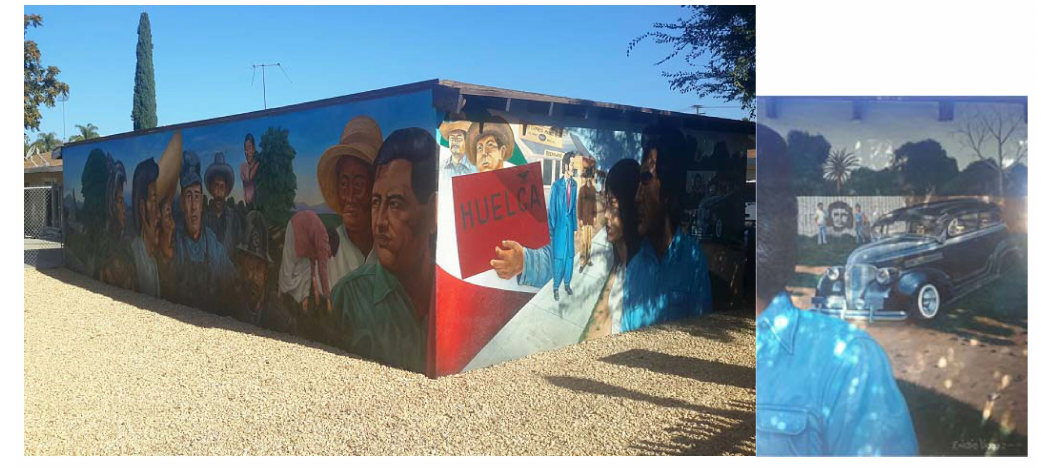
Figure 2. Emigdio Vasquez’s 1979 mural El Proletariado de Aztl á n is at the heart of the Orange Varrio Cypress (OVC) gang injunction zone. The Orange Police Department branded this a ‘gang mural’, citing a detail of Che Guevera (see detail). CU honoured Vasquez’s life and achievement as a muralist in 2010 (Source: James O’Neil Spady,